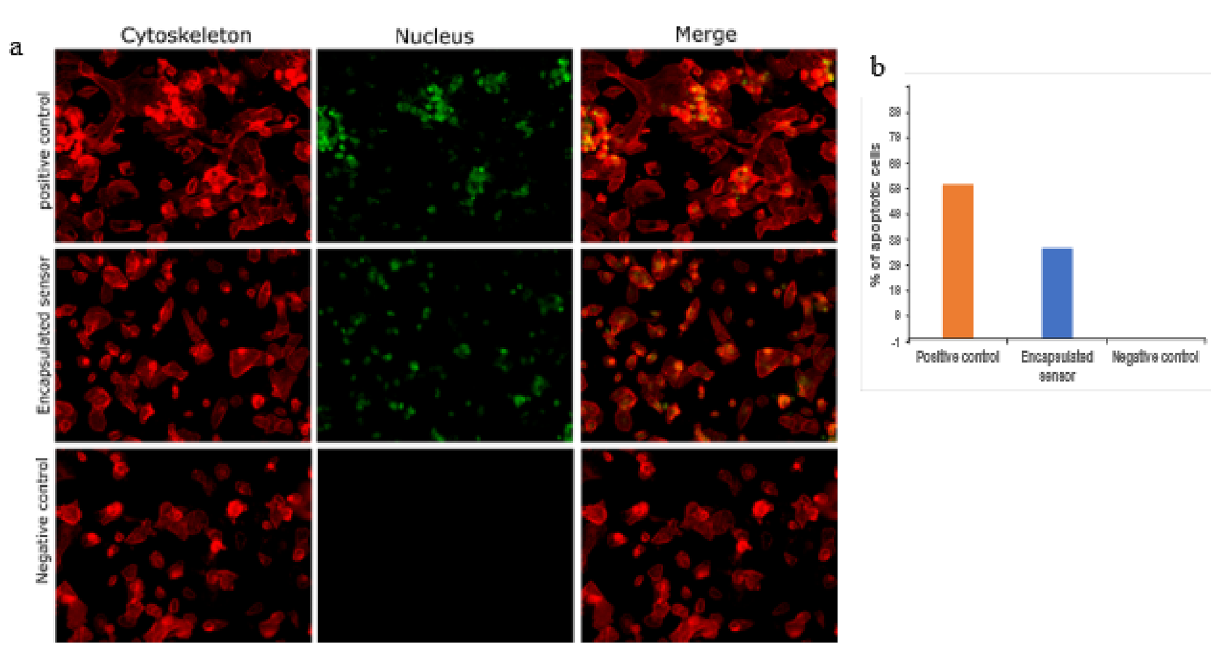
Figure 5. Caspase 3/7 activity assessment after a 24 h exposure to the different treatment groups on the epidermal cell line, HaCaT. ( a ) Representative fluorescent images (magnification: 20x) captured after treatment with positive control (cells treated with 10 µM of camptothecin for 12 h served as the positive control), an encapsulated sensor (encapsulated sensors fabricated using IC70 concentration of silver ink), and negative control (cells exposed to no treatment served as the negative control), ( b ) Quantitative representation of % of apoptotic cells after a 24 h exposure to the different treatment groups. The quantitation was performed using standard cell counting analysis of the obtained images ( n =